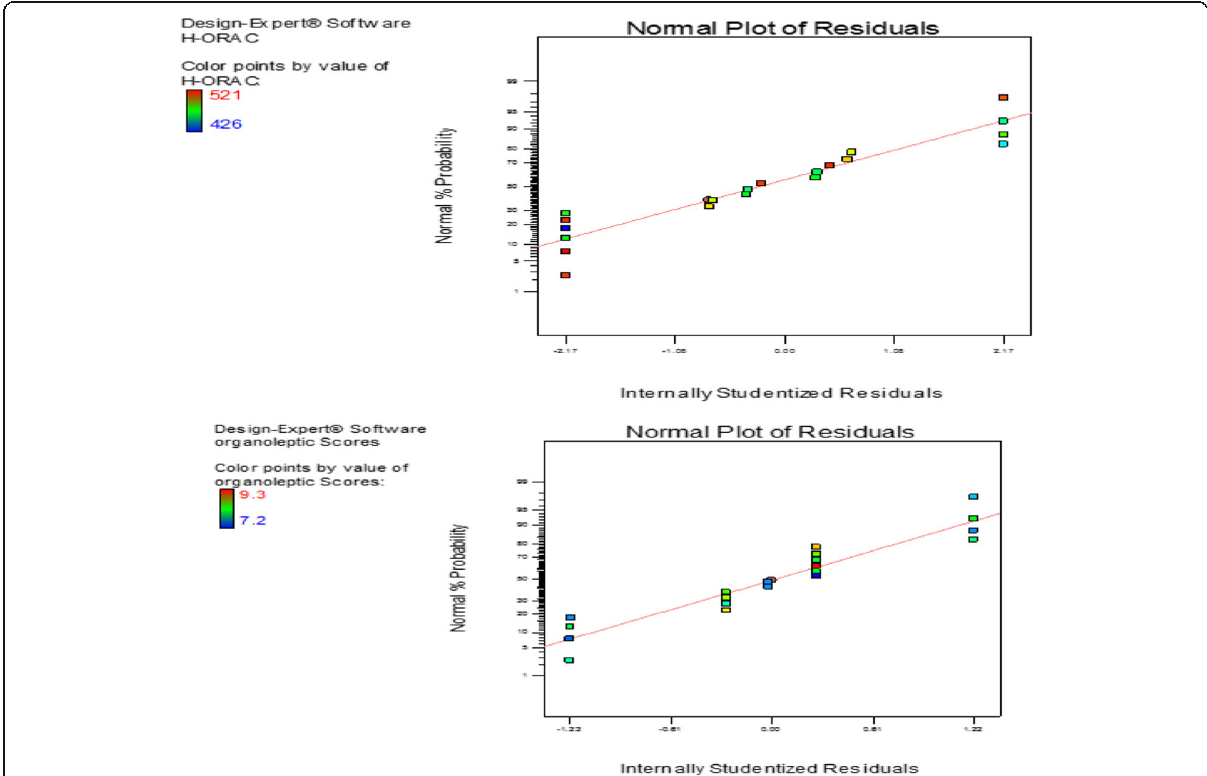
Fig. 1 Normal plot of residuals with ORAC value (above) as response 1 and organoleptic score (below) as response